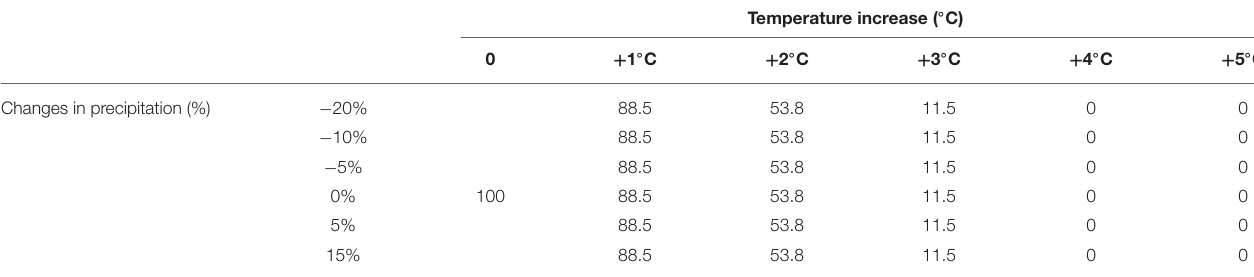
TABLE 3 | Risk of crop failure (%) for silage maize in